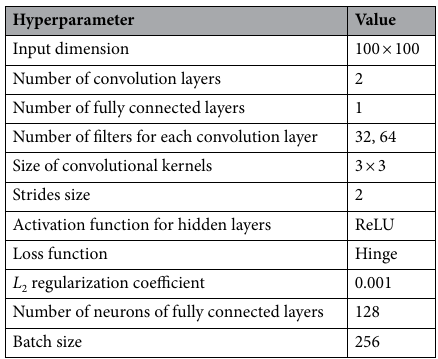
Table 2. Hyperparameters used to train the CNNs used in our experiments.